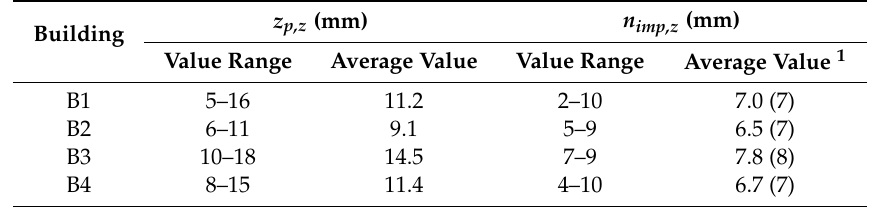
Table 4. The ranges of the surface disturbance zones ( z p,z ) and the quantities of impacts corresponding to the zone boundary ( n imp,z